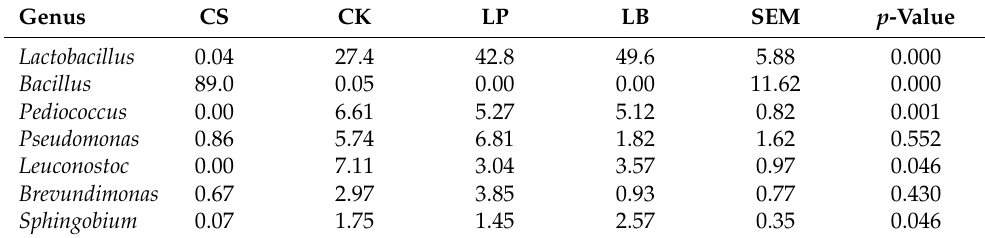
Figure 1. Relative abundance of bacterial community in whole crop corn silage at genus level. Note: FM is corn stover. CK, control silage; LP, corn silage treated with Lentilactobacillus plantarum ; LB, corn silage treated with Lentilactobacillus buchneri . Table 4. Relative abundance of dominant bacterial genera in whole crop corn silage.